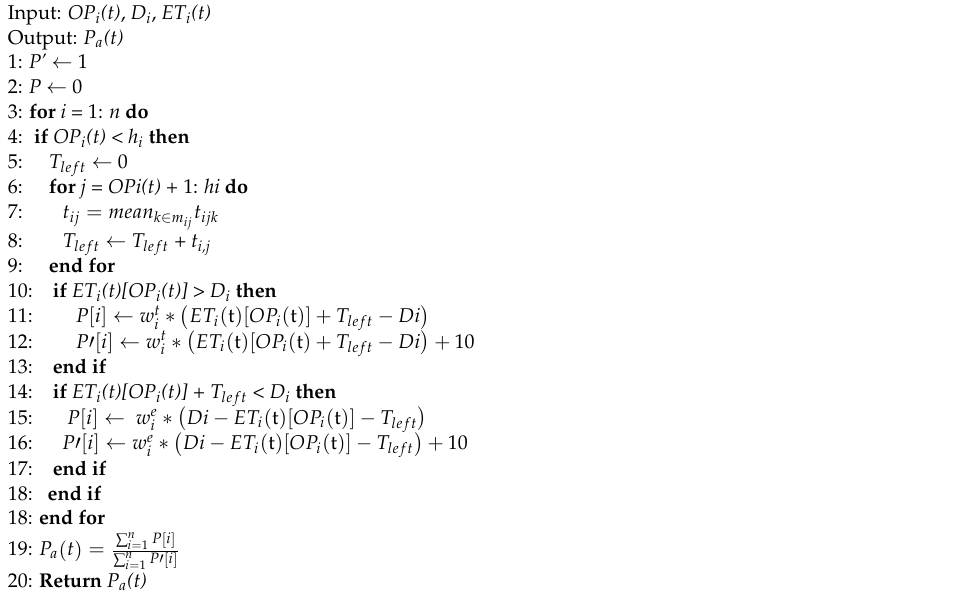
Algorithm 3 Procedure of calculating the actual earliness and tardiness penalty cost P a ( t